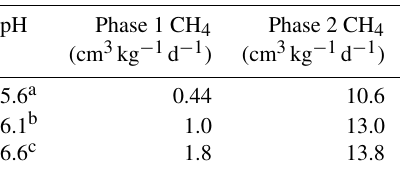
Different letters indicate a difference at p<